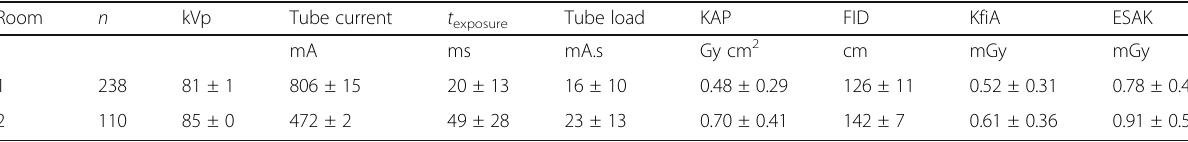
Table 2 Technique parameters AP pelvic radiography in our hospital (MUMC+) a Room